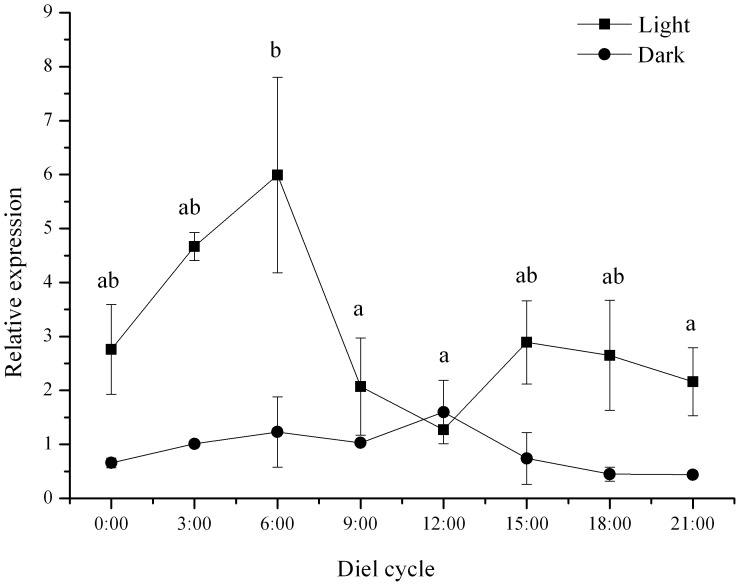
Relative expression of PAX 6 in tube feet of Strongylocentrotus intermedius under different light conditions during a diel cycle (N = 3, mean ± SE).Different letters above the line refer to significant difference in the group of light.